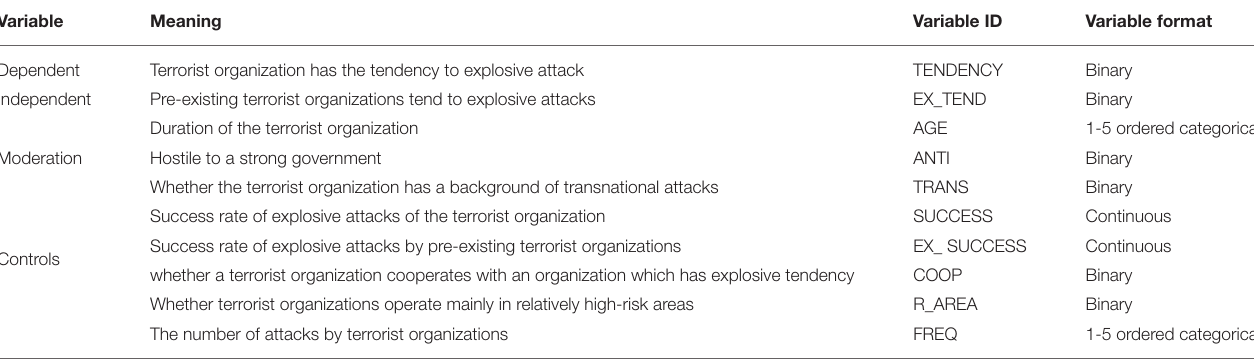
TABLE 2 | Variables identification and definition.